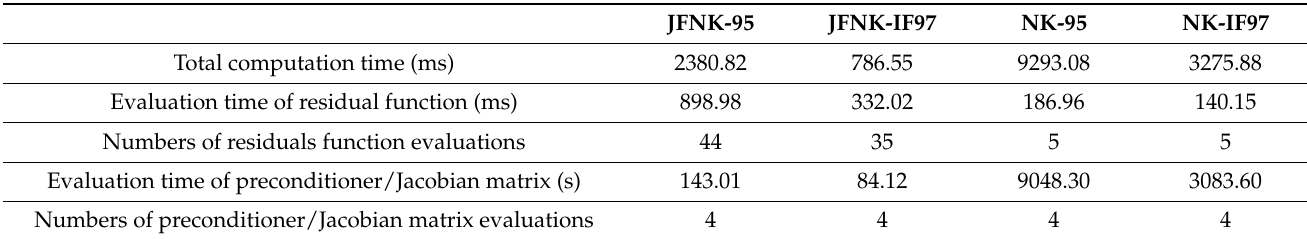
Table 8. Numerical computation time occupied by each part in the simulation.